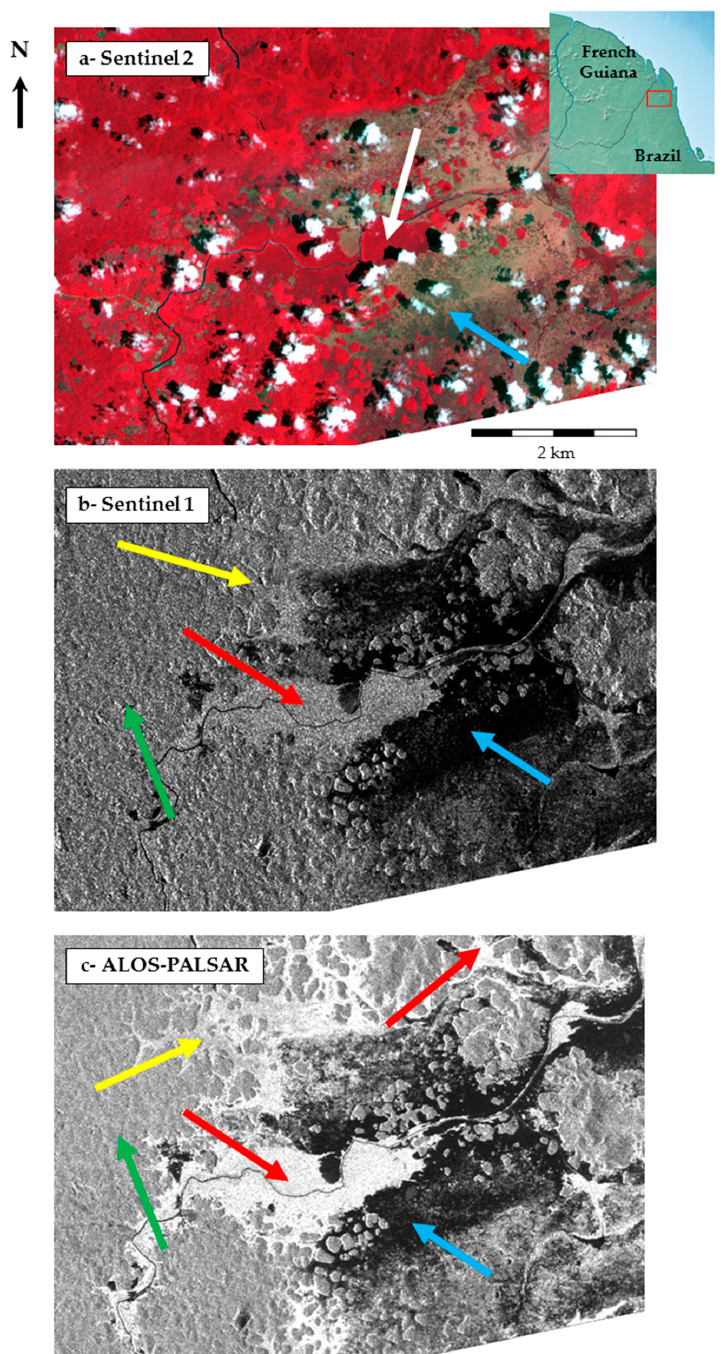
Figure 6. Comparison of reflectance and backscatter signal from Sentinel 2 optical image ( a ) dated September 2016, © European Space Agency—ESA, 2016, C-band SAR Sentinel 1 in VH polarization; ( b ) dated May 2016, © European Space Agency—ESA, 2016 and L-band SAR ALOS PALSAR in HH polarization; ( c ) dated May 2010, © JAXA, METI, 2010) on a wetland area in the Amazon, at the border between French Guiana and Brazil.